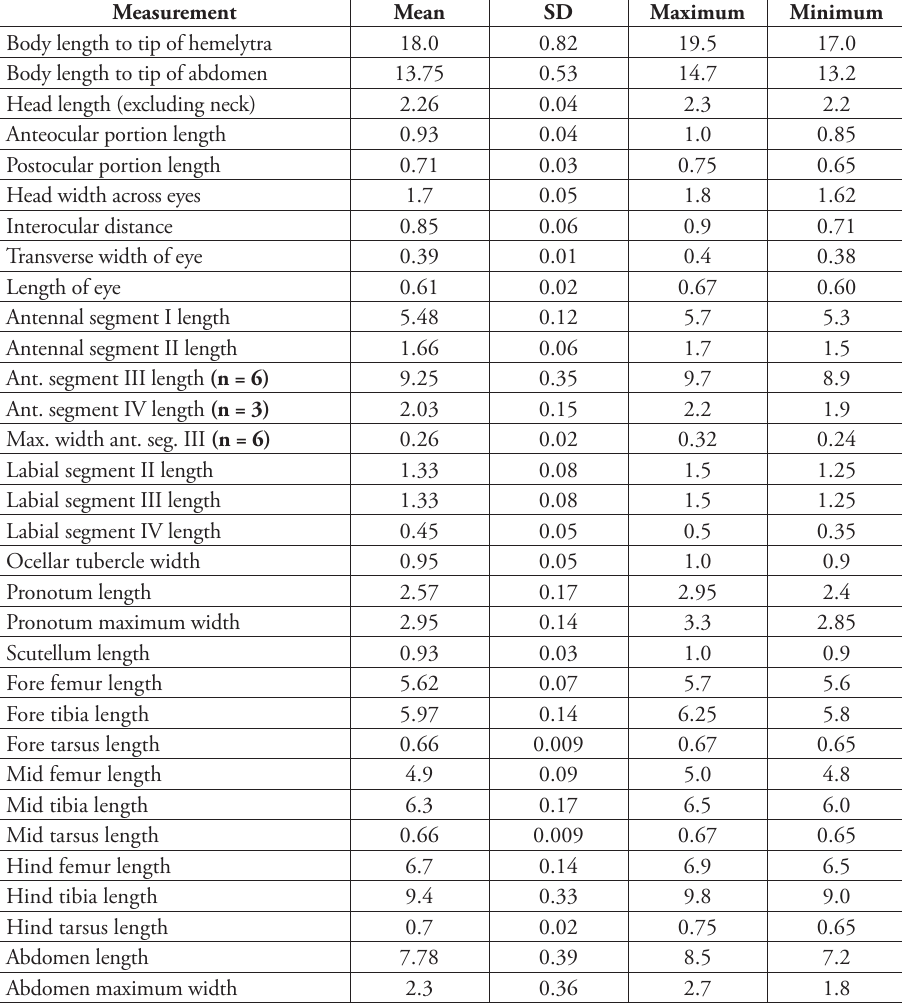
Table 1. Measurements (mm) of male specimens (N=9) of P. salgadoi from São Paulo State.